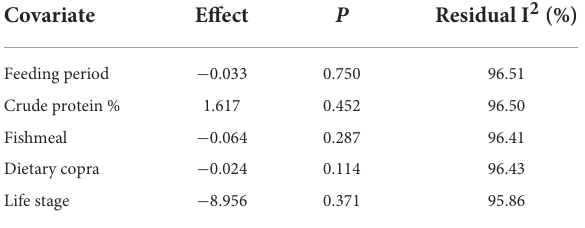
TABLE 4 Meta-regression for SGR.